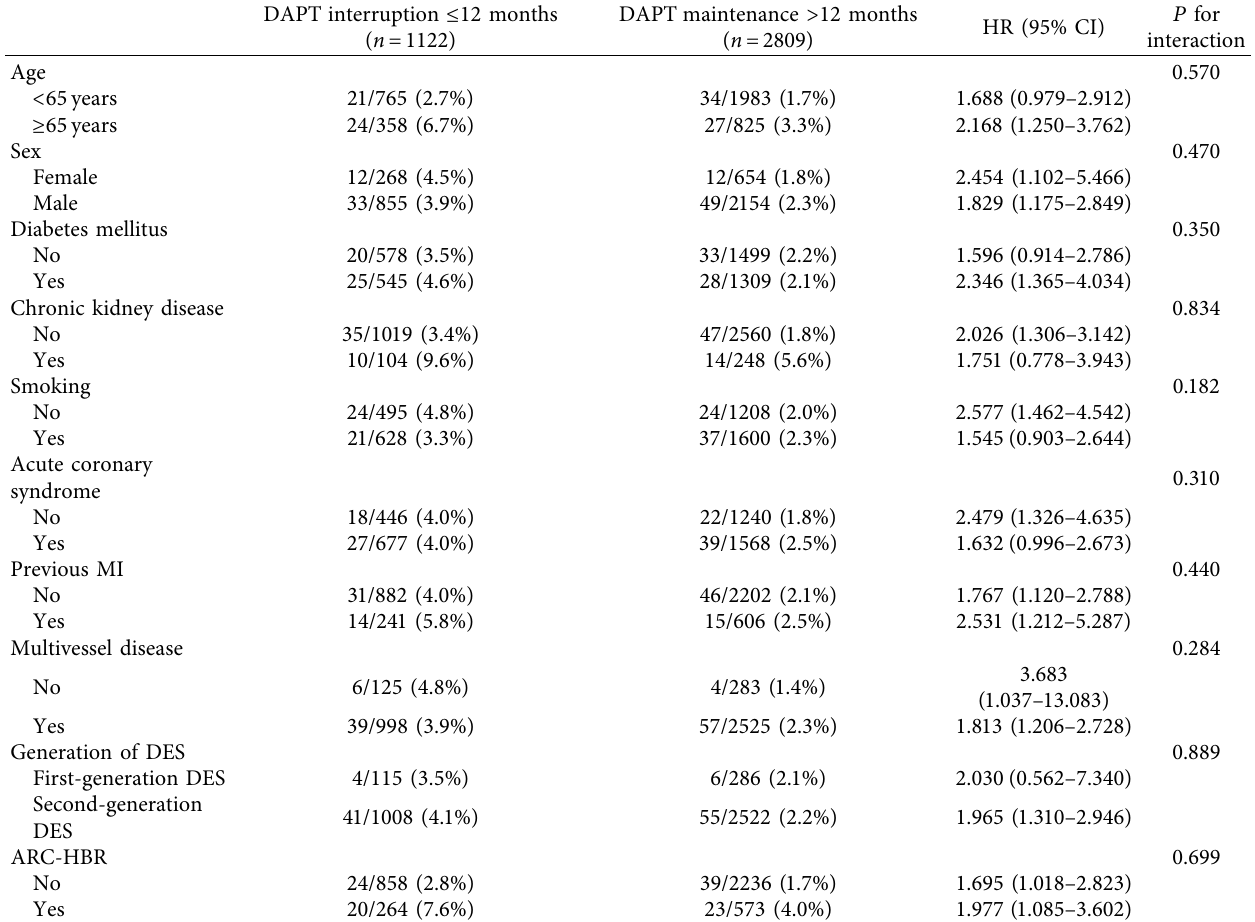
Table 4: Primary ischemic endpoint in selected